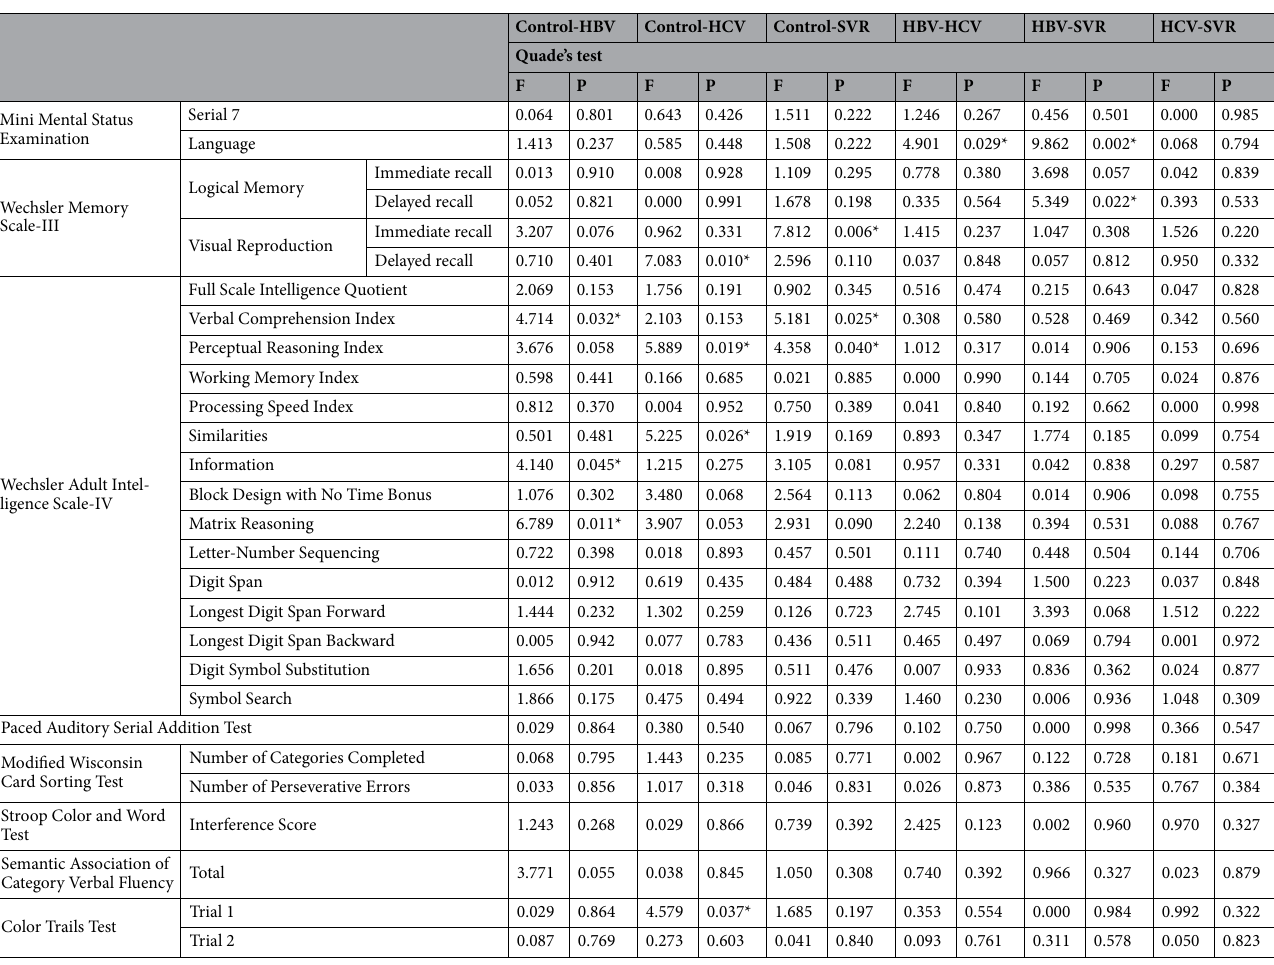
Table 4. Comparison of neurocognitive functions between the study groups with age, sex and education corrected. HBV hepatitis B virus, HCV hepatitis C virus, HTN hypertension, SD Standard deviation, SVR sustained virologic response. The F values stand for the variations between the sample means divided by the variation within the samples, derived from the Quade test (one-way ANOVA after ranking the dependent variables and the